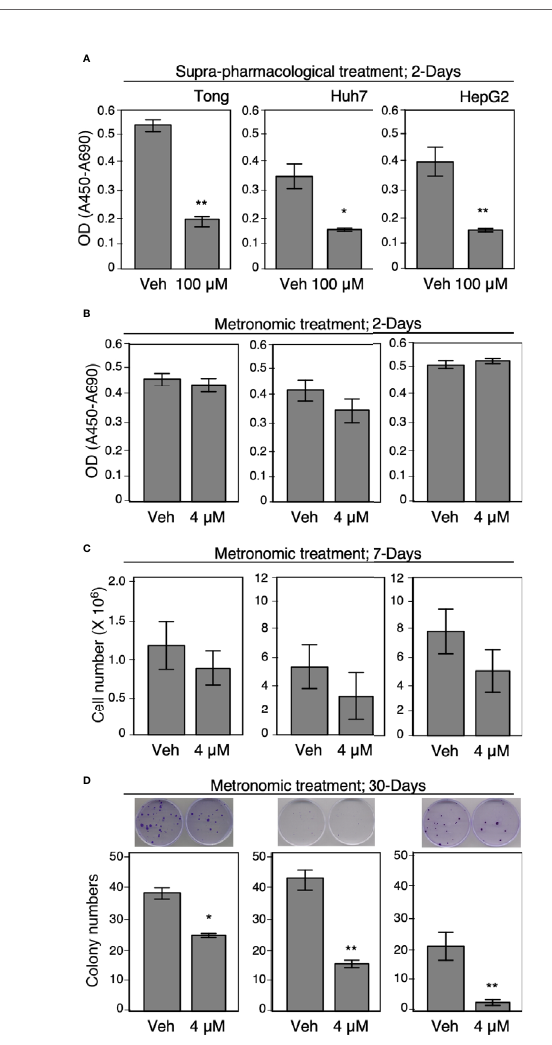
FIGURE 6 | Metronomic Celecoxib treatments reduced HCC cell growth. (A, B) Suprapharmacological (100 m M) treatment, or clinically available Celecoxib treatment (4 m M) for 2 days affect human HCC cell growth (Tong, Huh7, and HepG2). The cells were seeded on 96-well plates, and the cell growth was measured by adding WST-1 reagent into the culture medium. After 1 h of incubation, the optical density or absorbance (OD or Å450-Å690) was recorded and the readings were plotted on graph. Unlike supra- pharmacological treatment, short-term clinically available Celecoxib (4 m M, 2 days) could not cause signi fi cant suppression on cell growth. (C) Metronomic Celecoxib (4 m M, 7 days) treatments on HCC cells could exhibit a greater suppression of HCC cell counts than did vehicle-treated control cells. The cells were plated onto 60-mm dish (2 × 10 5 cells/plate) then treated with or without 4 m M Celecoxib, cultured for 7 days. The cell number was counted on day 7 by using plate cytometer, the total cell number was calculated, and the numbers were plotted on graph. (D) Long-term metronomic Celecoxib treatment (4 m M; 30 days) could reduce colony formation among the HCC cells. The HCC cells (500 cell/plate) were plated onto 60-mm dishes, treated with or without Celecoxib (4 m M), and were cultured for 30 days. The cells were fi xed with 4% buffered formalin, stained with trypan blue, and recorded as corresponding photos. The colony numbers were counted, and the values were plotted on the graph. The data were obtained from at least three reproducible independent experiments, and the mean values with standard errors were plotted. * Indicates P < 0.05 and ** indicates P < 0.01.